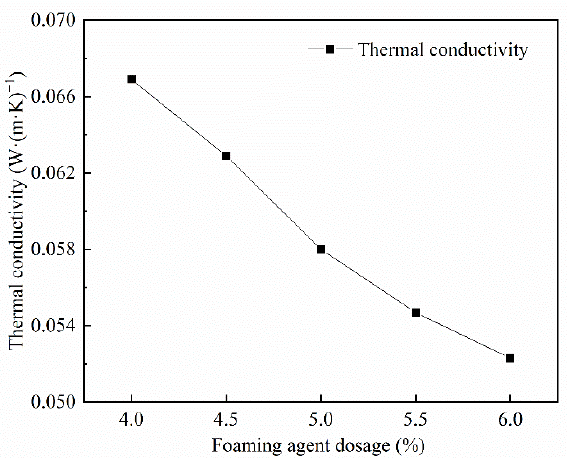
Figure 7. Influence of foam admixture on thermal conductivity.